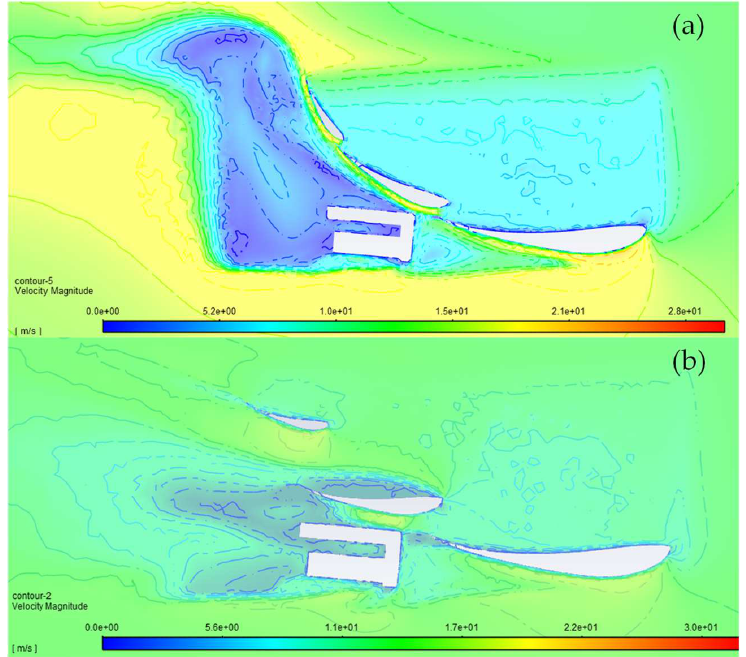
Figure 10. Speed contour near the endplate zone: ( a ) closed DRS; ( b ) open